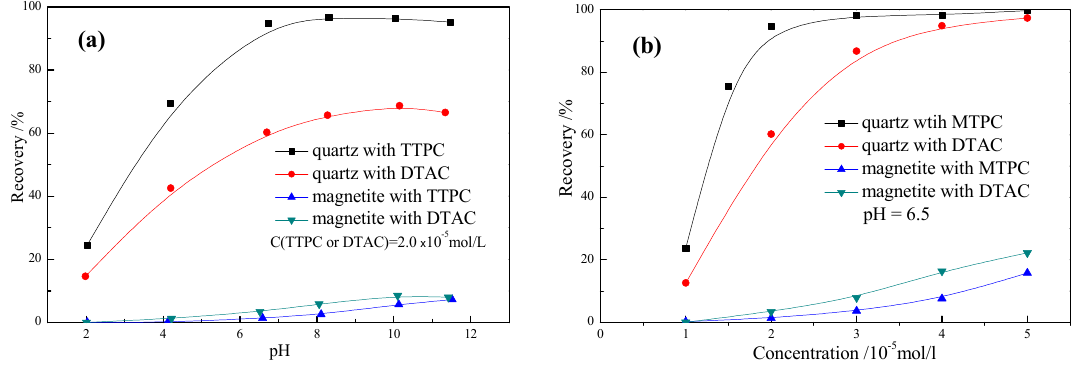
Figure 8. Flotation results of quartz and magnetite in the presence of TTPC and DTAC surfactants as a function of ( a ) pH and ( b ) the collector concentration.